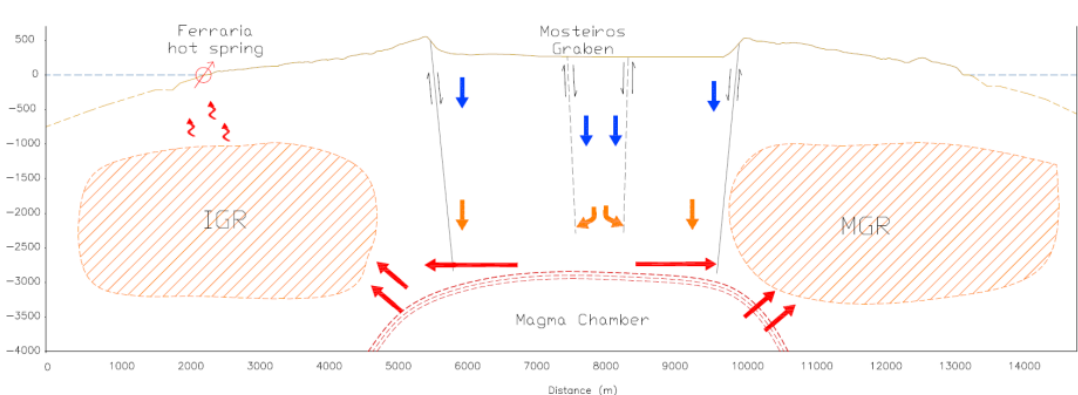
Figure 3. This sketch outlines the hydrothermal reservoir model of Sete Cidades based mostly on the interpretation (see A and B in Figure 2’s illustration) of published geological, geochemical, and geophysical data. Reproduced with permission from [22,23,27,29]. Society of Exploration Geophysicists and American Association of Petroleum Geologists, 2017.